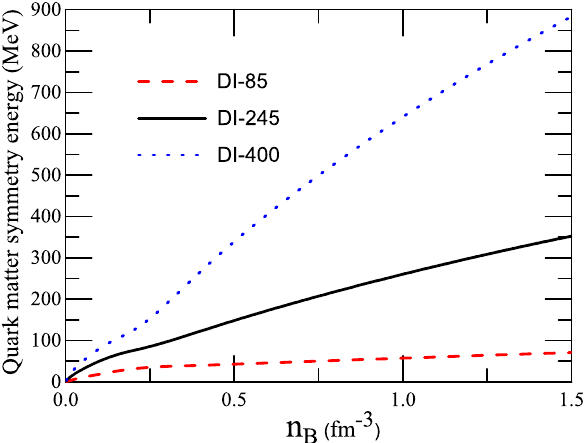
Fig. 1 Symmetry energy as functions of baryon number density with DI-85, DI-245 and DI-400